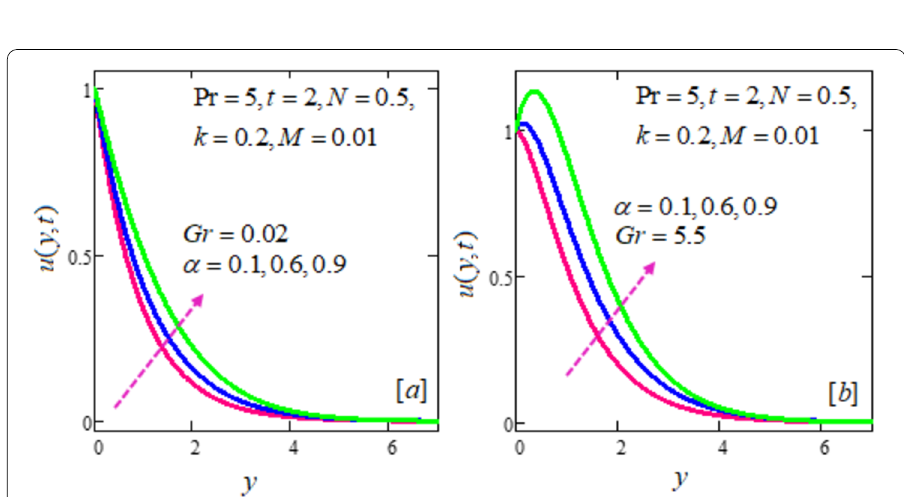
Figure 4 Velocity profile variation with fractional parameter α and Grashof number Gr